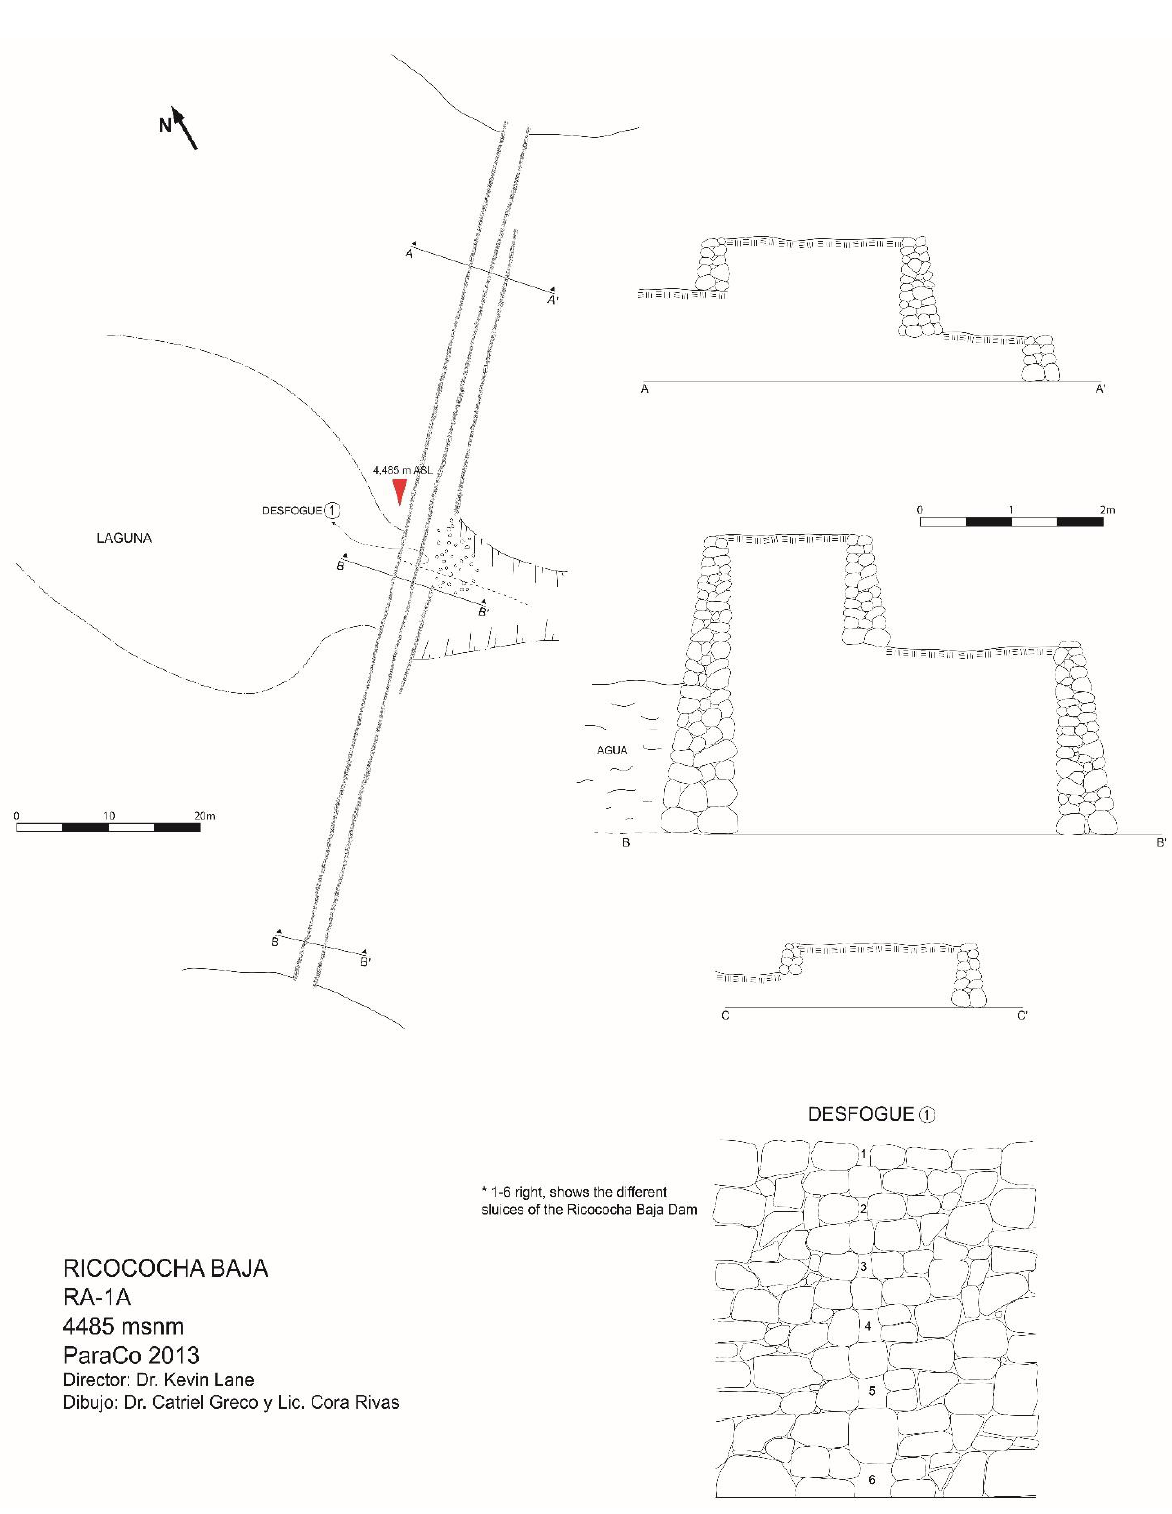
Figure 8. Plan and profile of Ricococha Baja [Ra 1].